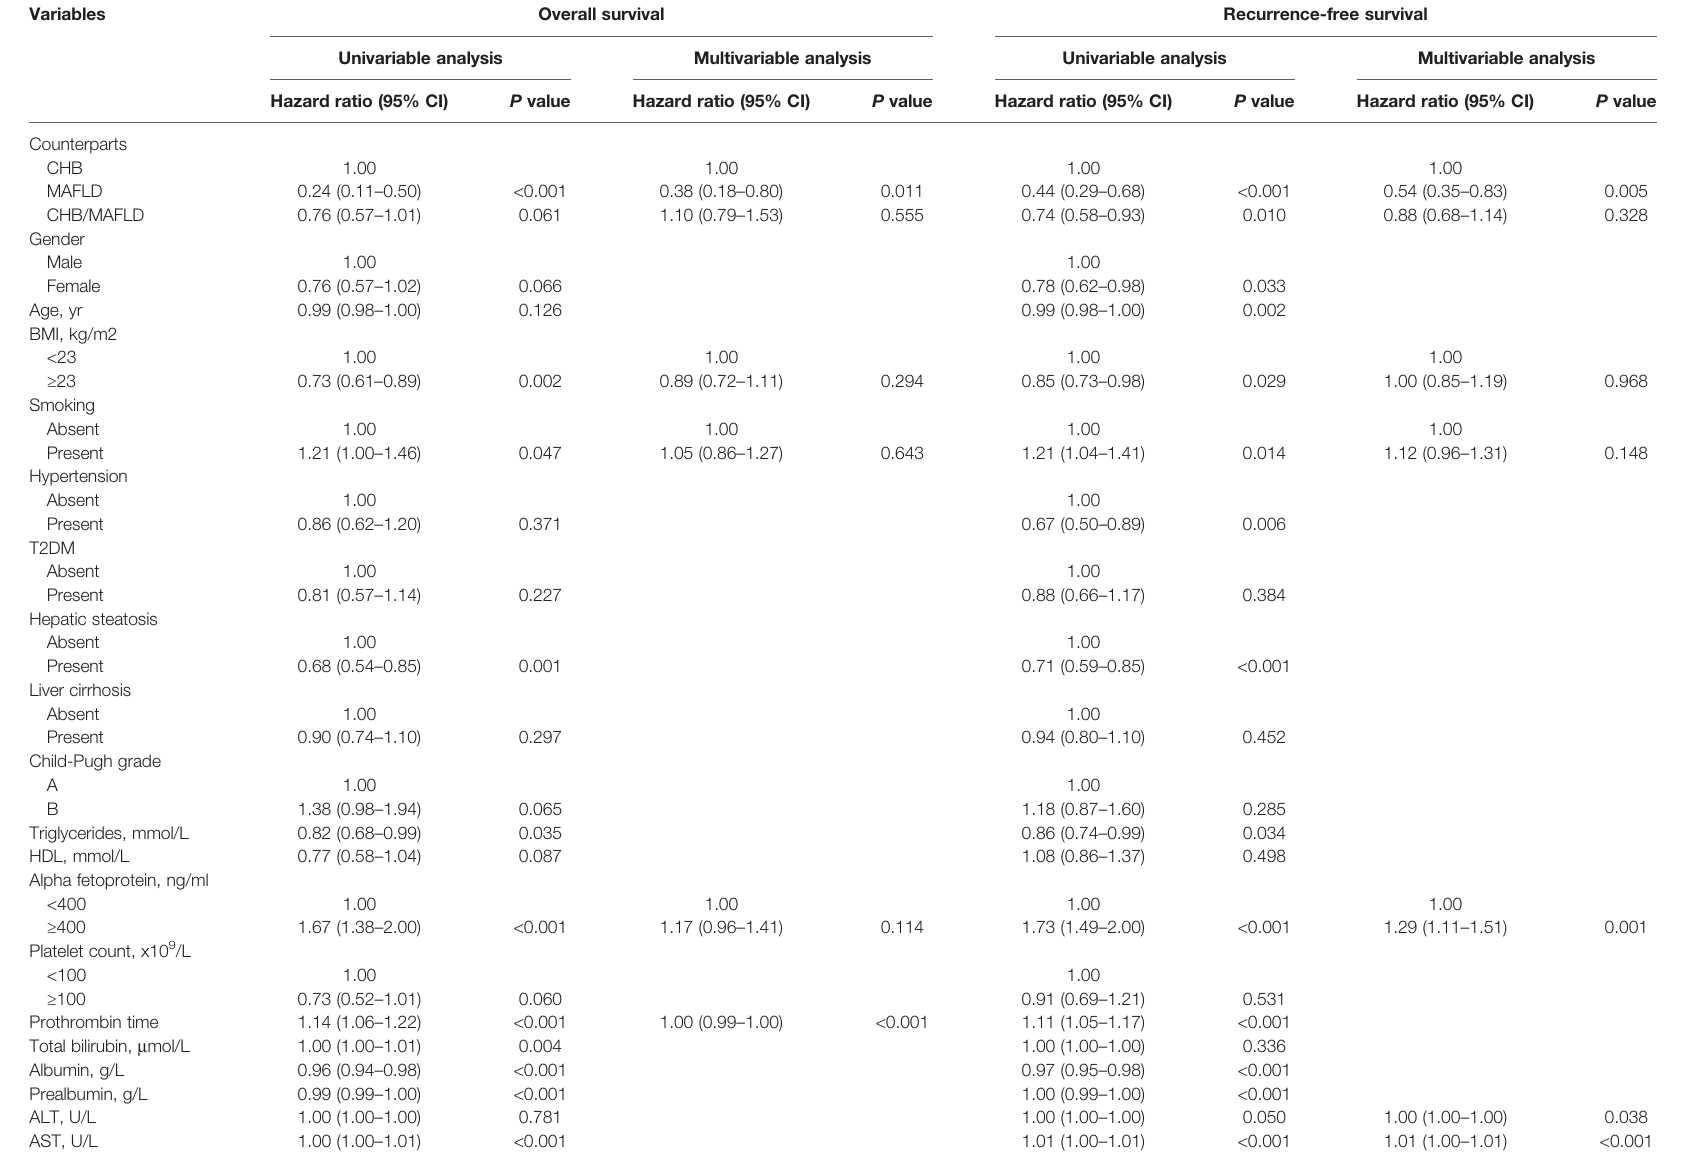
TABLE 2 | Risk factors of overall and recurrence-free